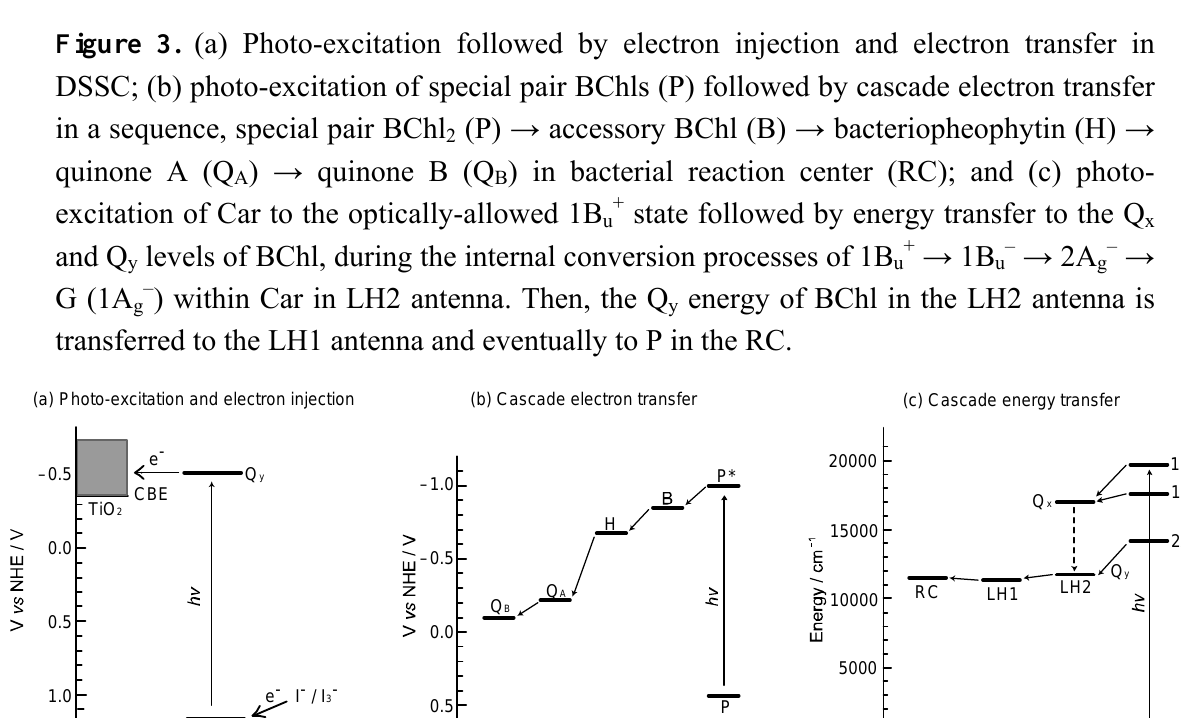
Figure 3. (a) Photo-excitation followed by electron injection and electron transfer in DSSC; (b) photo-excitation of special pair BChls (P) followed by cascade electron transfer in a sequence, special pair BChl (P) → accessory BChl (B) → bacteriopheophytin (H) → 2 quinone A (Q ) → quinone B (Q ) in bacterial reaction center (RC); and (c) A B